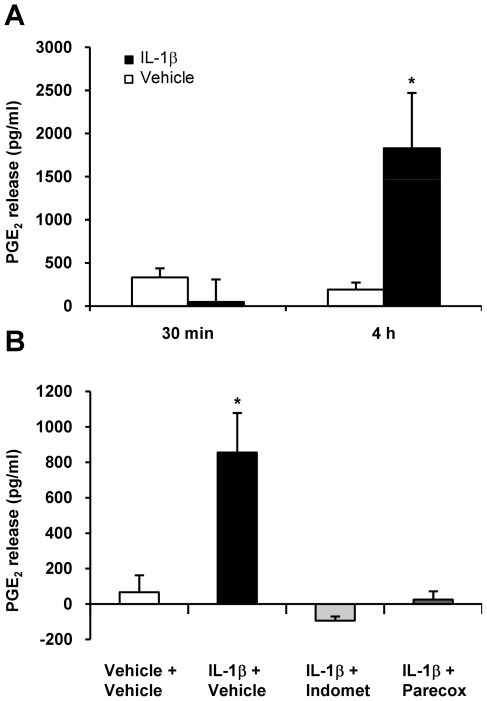
Induction of PGE2 levels in trigeminal ganglia cell culture after stimulation with IL-1β.PGE2 levels were significantly increased in TGC 4 hours after stimulation with IL-1β (10 ng/ml) compared to vehicle (A). No effect on PGE2 release was seen 30 minutes after stimulation with IL-1β compared to vehicle (n = 4/group). Dependency of IL-1β induced PGE2 release on COX-2 activity is shown in (B). 15 min of incubation with the selective (parecoxib, 10 µM) or the non-selective (indomethacin, 10 µM) COX-2 inhibitor completely aborted IL-1β induced PGE2 release after 4 hours. PGE2 levels are illustrated as mean pg/ml ± SEM compared to baseline. *p<0.05 compared to vehicle (n = 3-4/group).